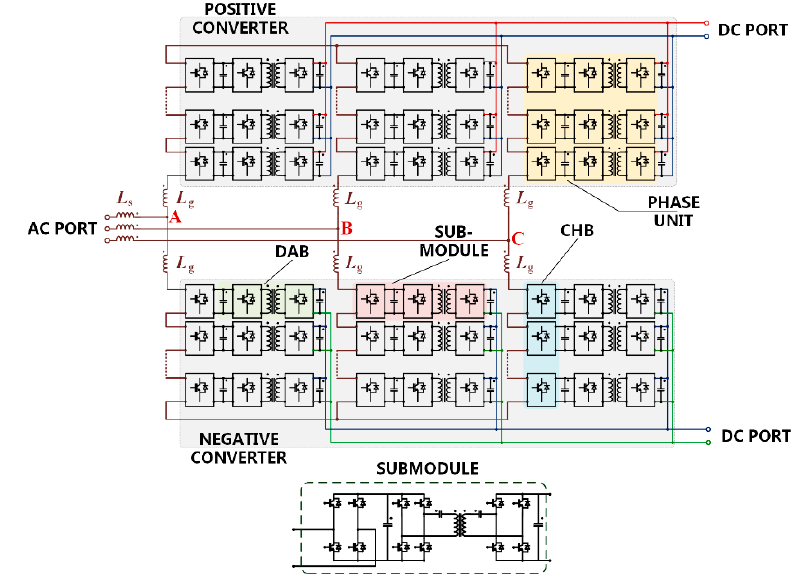
Figure 1. The circuit topology of MP-PET.